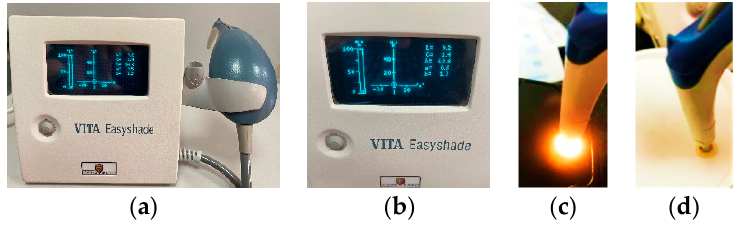
Figure 2. The Vita Easyshade device used to measure the L*, a*, and b* color coordinates for each sam- ple in the non-aged and aged groups ( a , b ). Samples tested with black and white backgrounds ( c , d